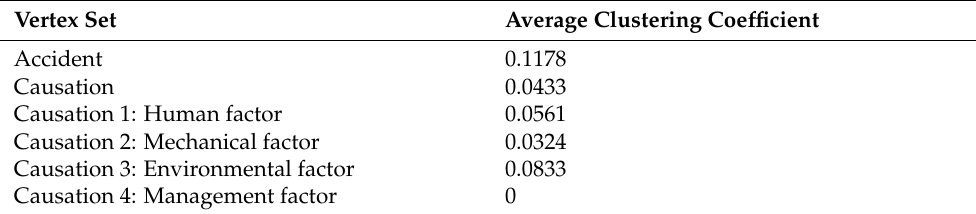
Table 7. The average clustering coefficient of various types of vertex